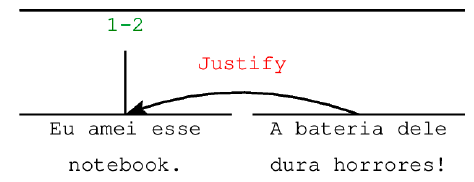
Figure 1. Rhetorical structure (RST) annotation for the short text Eu amei esse notebook. A bateria dele dura horrores! (“I loved this notebook. Its battery lasts a long time!”).